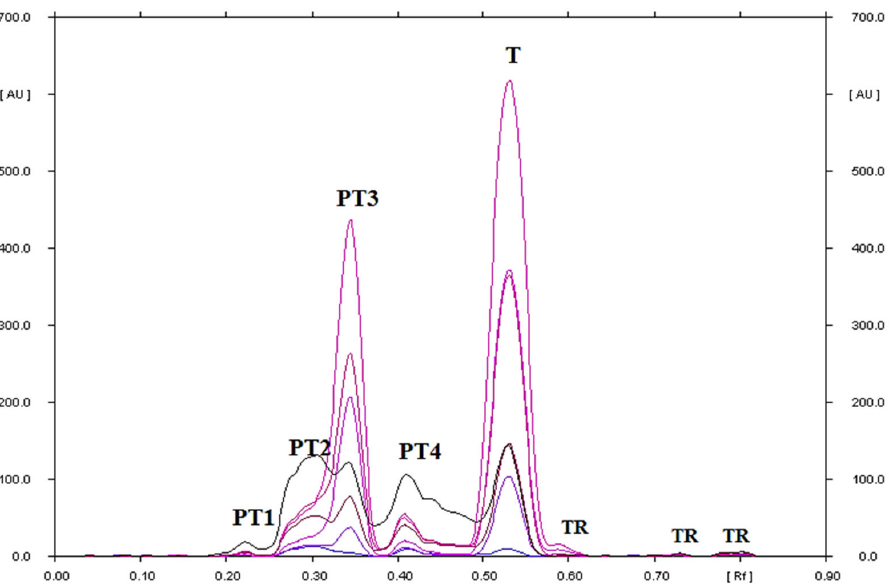
Figure 13. TLC-UV densitograms recorded in the multi wavelength from 200 to 380 nm (at wave- length intervals of 30 nm at each step) of tinidazole in water at pH = 5.56 solution (II), which after heating at 40 °C for 1000 h was separated on silica gel using a mobile phase chloroform–methanol (9:1, v / v ), where T is tinidazole, PT1, PT2, PT3, and PT4 are the degradation products of tinidazole, and TR is the traces; PT3 was identified as